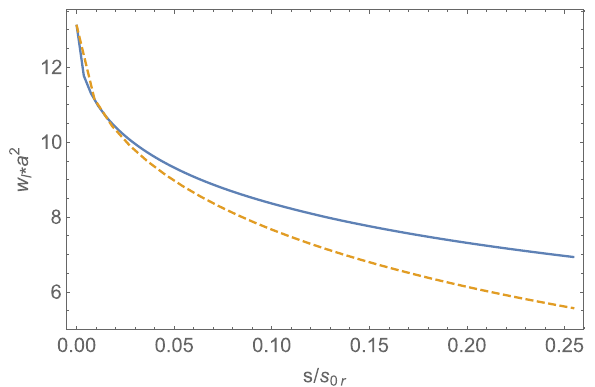
FIG. 5. Longitudinal wake off axis by y ¼ 0 . 5 mm, comparing the numerical inverse Fourier transform of the general impedance equation, Eq. (10) (blue curve), with the first order approxima- tion, Eq. (15) (the dashes).